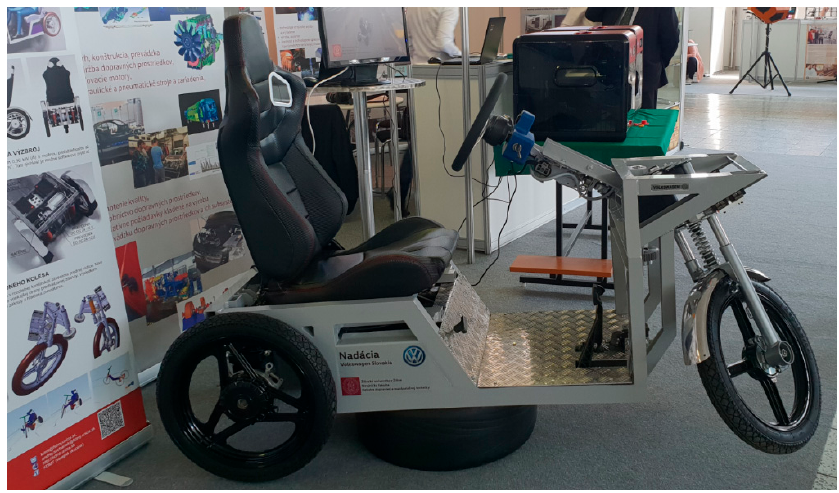
Figure 29. Real model of the designed vehicle.